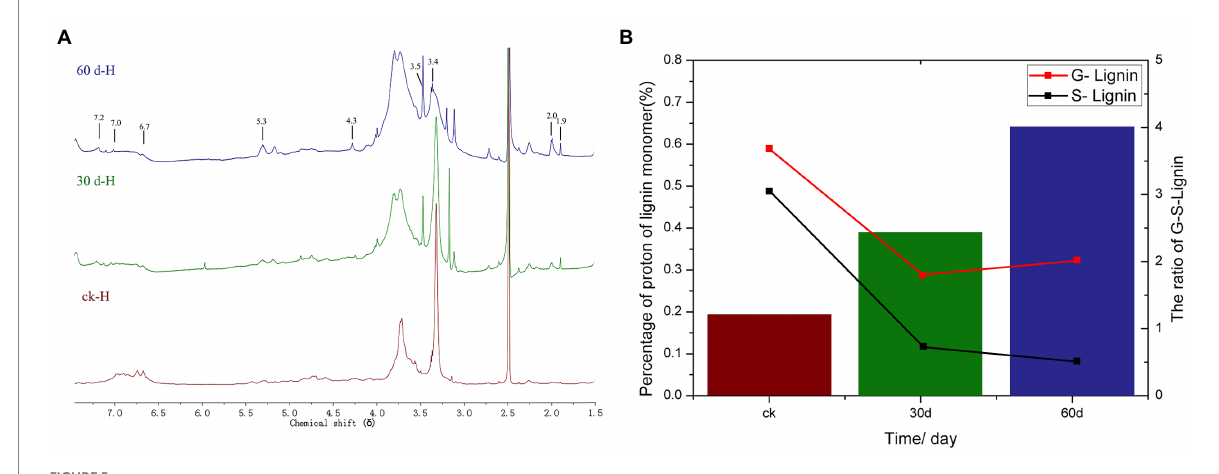
FIGURE 5 1 H NMR analysis of cotton stalks control and degraded by P. ostreatus for 30 and 60 days. (A) 1 H-NMR spectra of acetylated MWL from the cotton stalks at various degradation stages. (B) Percentage and ratio of G lignin units and S lignin units in acetylated MWL from the cotton stalks at various degradation